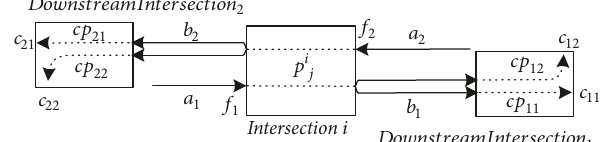
Figure 5: Coordination relationships of light phases among adjacent intersections.